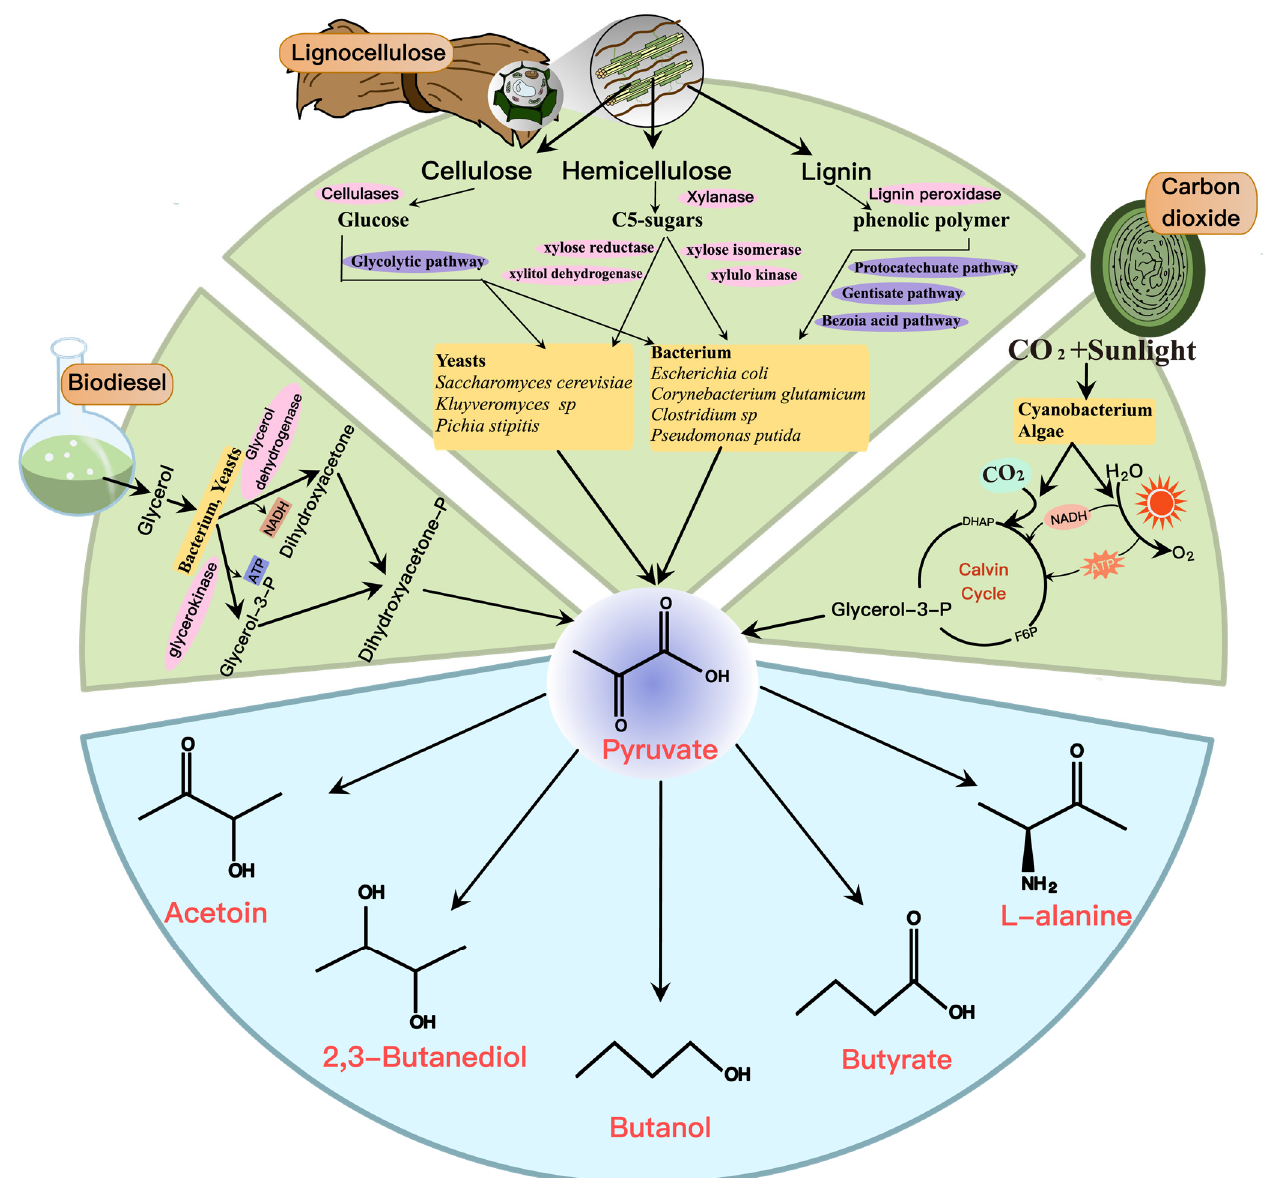
Figure 6. Alternative feedstocks for the production of pyruvate and derivatives, such as lignocellulose, biodiesel, and CO 2 . The yellow boxes are the microorganisms that have been implemented, the purple ovals are the important pathways involved in alternative feedstock utilization, and the pink ovals are the main enzymes involved in alternative feedstock utilization